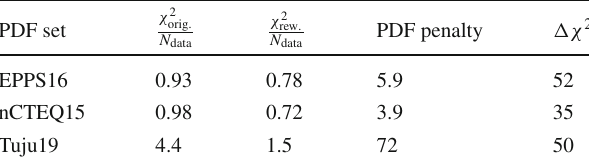
Table 1 The values of χ 2 / N data for the original central PDF set and for the central set after re-weighting analysis. The induced penalties and original tolerance criteria (cid:4)χ 2 are indicated as well χ 2 orig . PDF set N